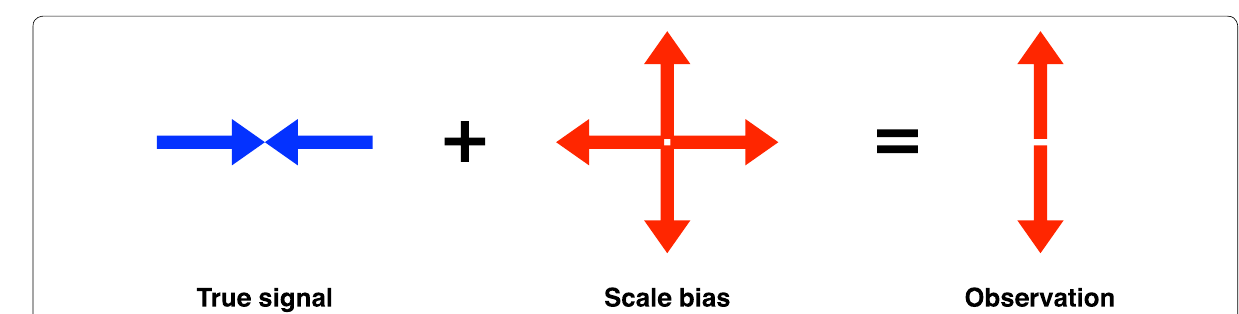
Fig. 3 Schematic diagram showing an apparent N–S extension as a sum of a true E–W contraction signal plus an isotropic scale